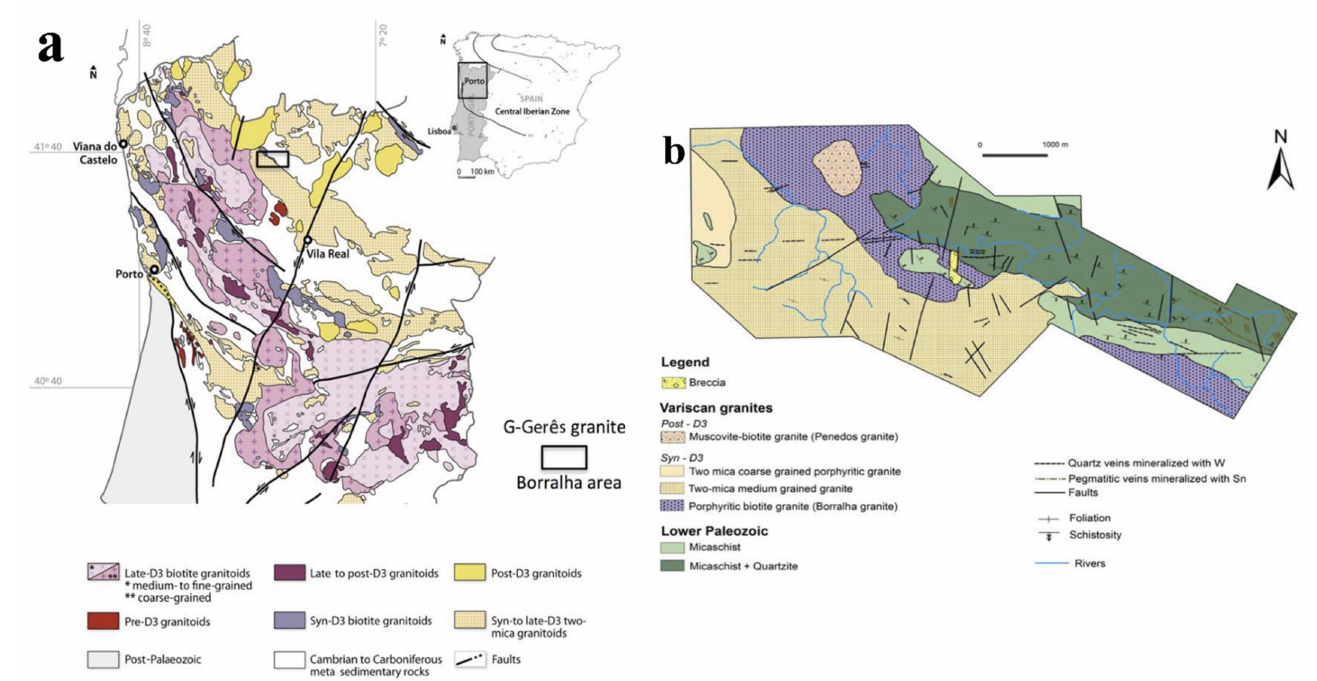
Figure 1. ( a ) Geological map of the northern part of Portugal and location of the W, (Cu,Mo) ore deposit of Borralha, Ger ê s Mountains [35]. ( b ) Geological map of the Borralha region [40]. (Both figures are reproduced from Bobos et al. [28] with permission of the Mineralogical Society of Great Britain and